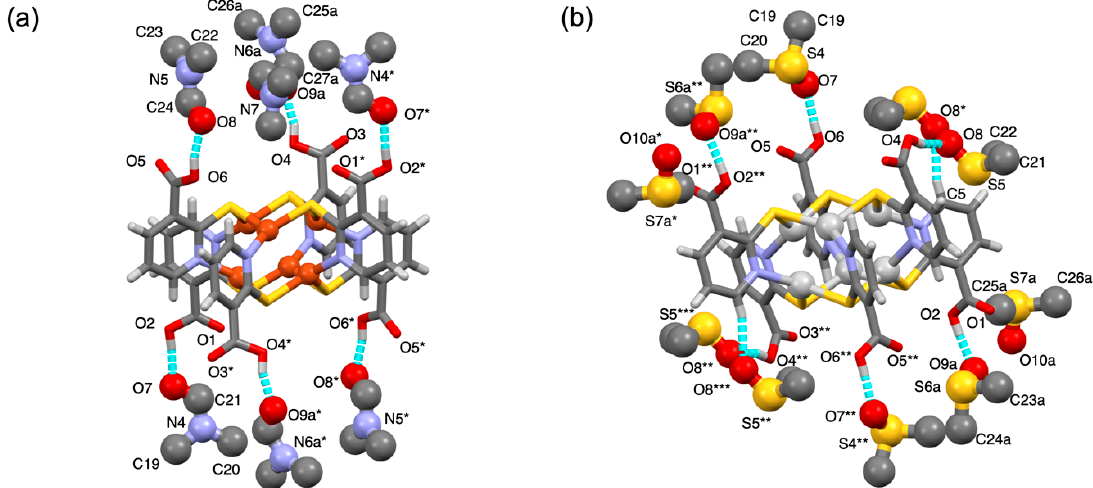
Figure 3. Views of the molecular structures with H-bonded guests in ( a ) 1 · 7DMF and ( b ) 2 · 8DMSO. Hexanuclear paddle- wheels ( 1 and 2 ) and solvent guest molecules (DMF and DMSO) are depicted in stick and ball-and-stick models, respectively. H-bonds are shown in broken cyan lines. Interatomic distances for H-bonds ( d O ··· O , d C ··· O , Å) are as follows. For 1 · 7DMF, O2 · · · O7 = 2.555, O6 · · · O8 = 2.552, and O4 · · · O9a = 2.534. For 2 · 8DMSO, O2 · · · O9a = 2.546, O4 · · · O8 = 2.546, O6 · · · O7 = 2.556, and C5 · · · O8* = 3.182. Color codes: Cu, brown; Ag, light gray; S, yellow; O, red; N, blue; C; gray; H, pale gray. Hydrogen atoms of solvent molecules are omitted for clarity. Symmetry codes: (*) 1 − x , 1 − y , 1 − z ; (**) 1 − x , 2 − y , 1 − z ; (***) x , 1 + y , z .